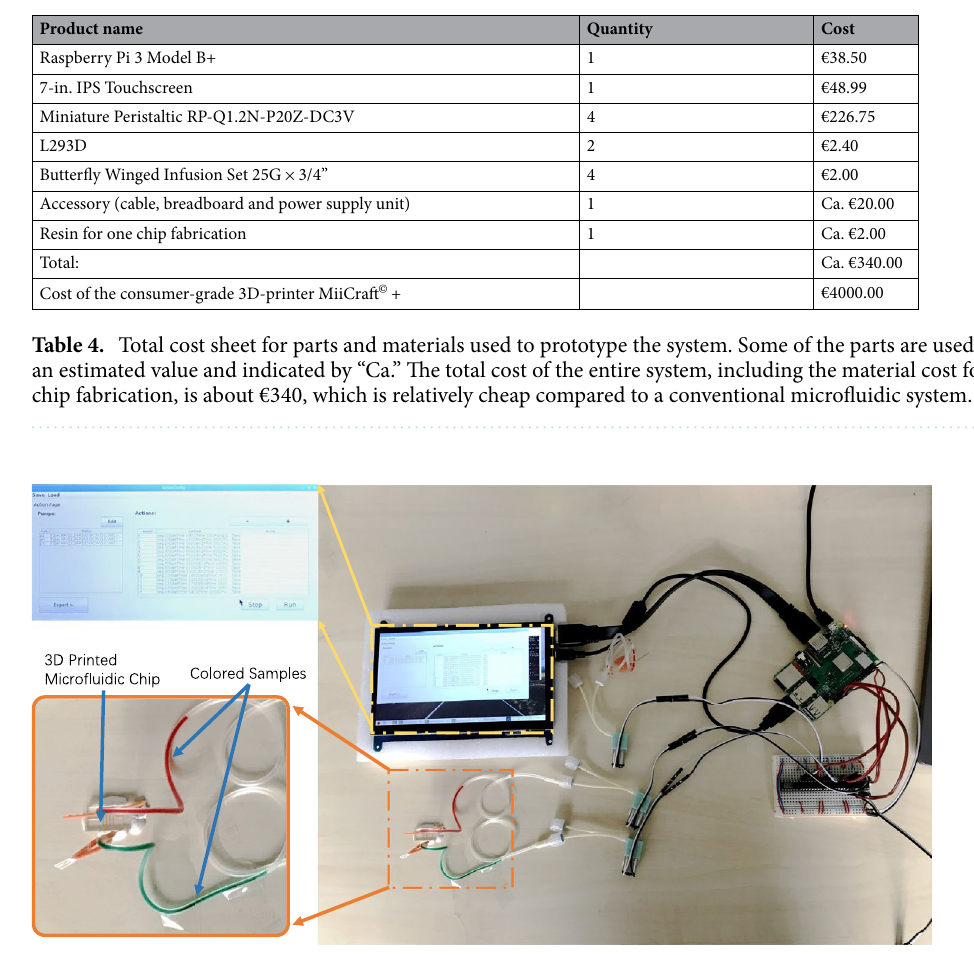
Figure 4. Picture of all parts of the all-in-one portable microfluidic system interconnected. All experiments are performed under this circumstance. The 3D-printed microfluidic is positioned on the table using sticky clay. The fluid samples are directly filled in the tubing. All operations are done via the touch